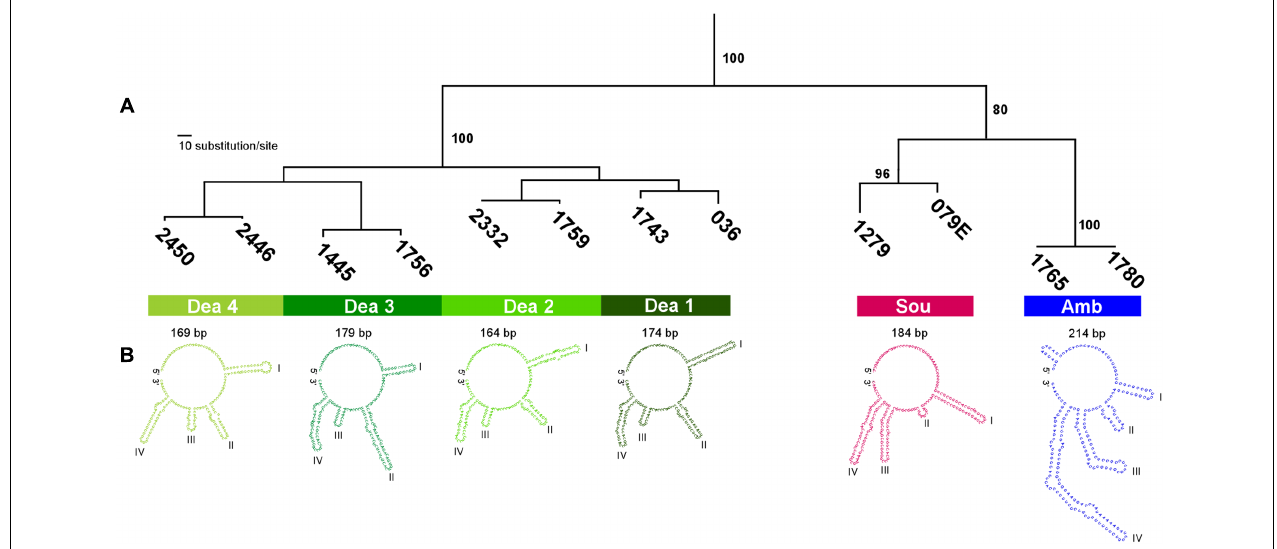
FIGURE 5 | Analyses of ITS1 rDNA sequences from Angomonas species and genotypes. (A) Dendrogram (parsimony) of ITS1 rDNA sequences from A. ambiguus , A. desouzai, and genotypes (Dea1–Dea4) of A. deanei . The numbers at the node correspond to bootstrap values ( > 50%) from 500 replicates. (B) Predicted secondary structures of ITS1 rDNA sequences from Angomonas species and genotypes showing an open loop and four main helices that varied in length according to species and main genotypes of A. deanei . The estimated values of thermodynamic energy of modelled structures ( (cid:49) G Kcal/mol) for each species were: A. deanei (–54.4), A. desouzai (–69), and A. ambiguus (–83.3). Sou, A. desouzai ; Amb, A. ambiguus ; Dea1–Dea4, A. deanei genotypes. GenBank accession numbers of ITS1 rDNA sequences included in this analysis are shown in Supplementary Table 2.